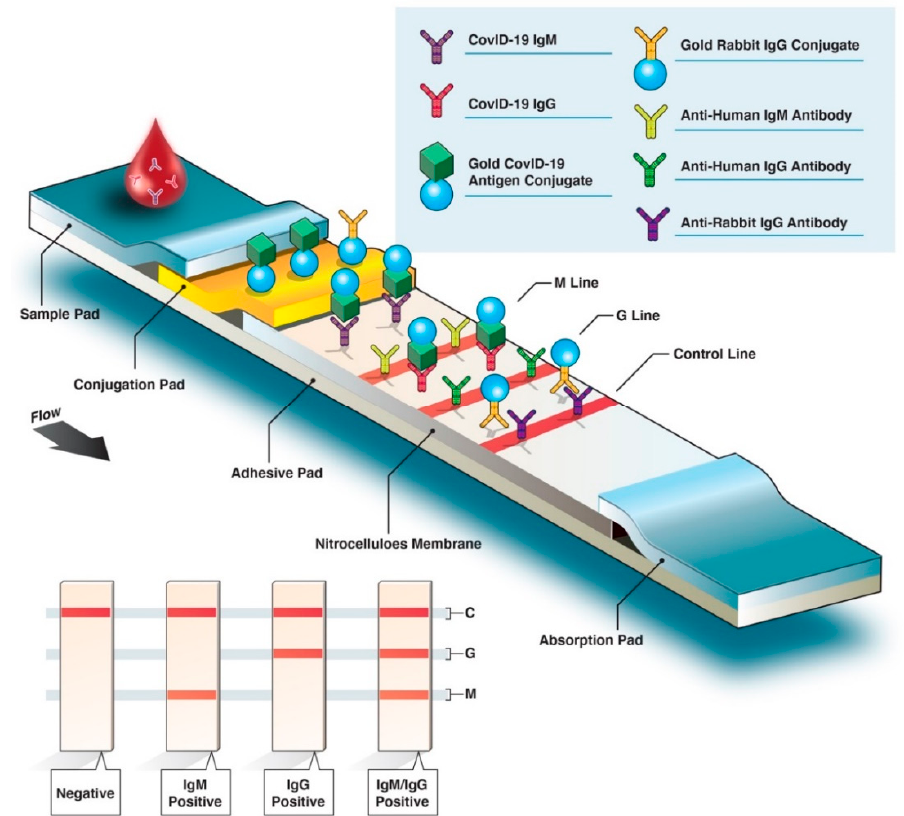
Figure 2. Overview of rapid diagnostic serological test. Rapid diagnostic tests (RDTs) are typically based on colorimetric lateral flow immunoassay, in which host antibodies migrate across an adhesive pad (e.g., nitrocellulose) and interact with bound virus-specific antigens and secondary antibodies (antihuman IgM / G antibodies). Conjugated SARS-CoV-2-specific antigen(s) (labeled with gold here) will bind with the corresponding host antibodies. As antibody–antigen complexes travel up the membrane, bound anti-SARS-CoV-2 IgM antibodies interact with fixed anti-IgM secondary antibodies on the M line, and anti-SARS-CoV-2 IgG antibodies interact with anti-IgG antibodies on the G line. If the blood sample does not contain SARS-CoV-2-specific antibodies, the M or G lines do not appear in the final test results; only the control (C) line will be revealed.